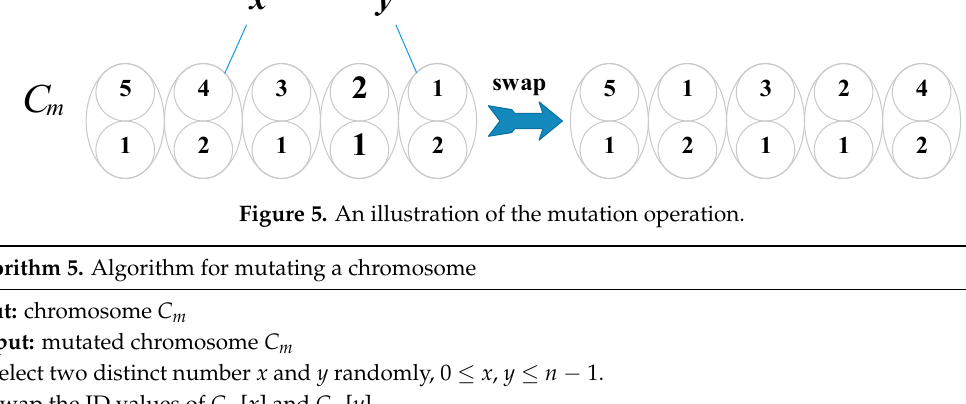
Algorithm 5. Energies 2019 , 12 , x FOR PEER REVIEW Algorithm 5. Algorithm for mutating a chromosome